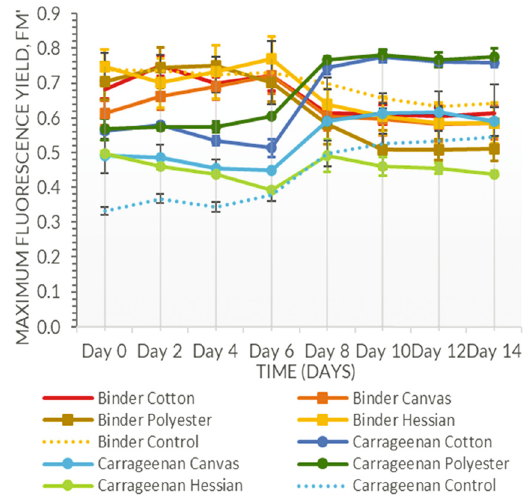
Figure 3: Closed incubation cotton samples with the following matrices: Aloe vera ( mean StDev = 0.049 ) and control ( mean StDev = 0.038 ) , chitosan ( mean StDev = 0.004 ) and control ( mean StDev = 0.002 ) , binder ( mean StDev = 0.027 ) and control ( mean StDev = 0.045 ) , carrageenan ( mean StDev = 0.014 ) and control ( mean StDev = 0.022 ) in full strength BG11 media.